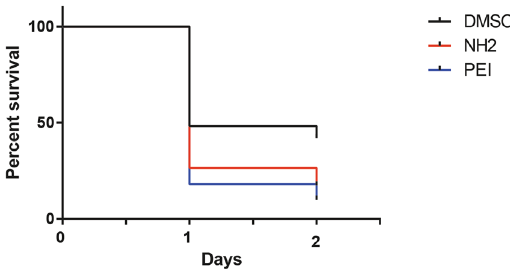
Figure 7. Bypass of biological barriers by microinjection increases toxicity of NH2-MSNs. Percentage survival of zebrafish embryos microinjected with 20 + / − 12 ng/embryo NH 2 -MSNs (n = 111) and PEI-MSNs (n = 98), or with DMSO control alone (n =